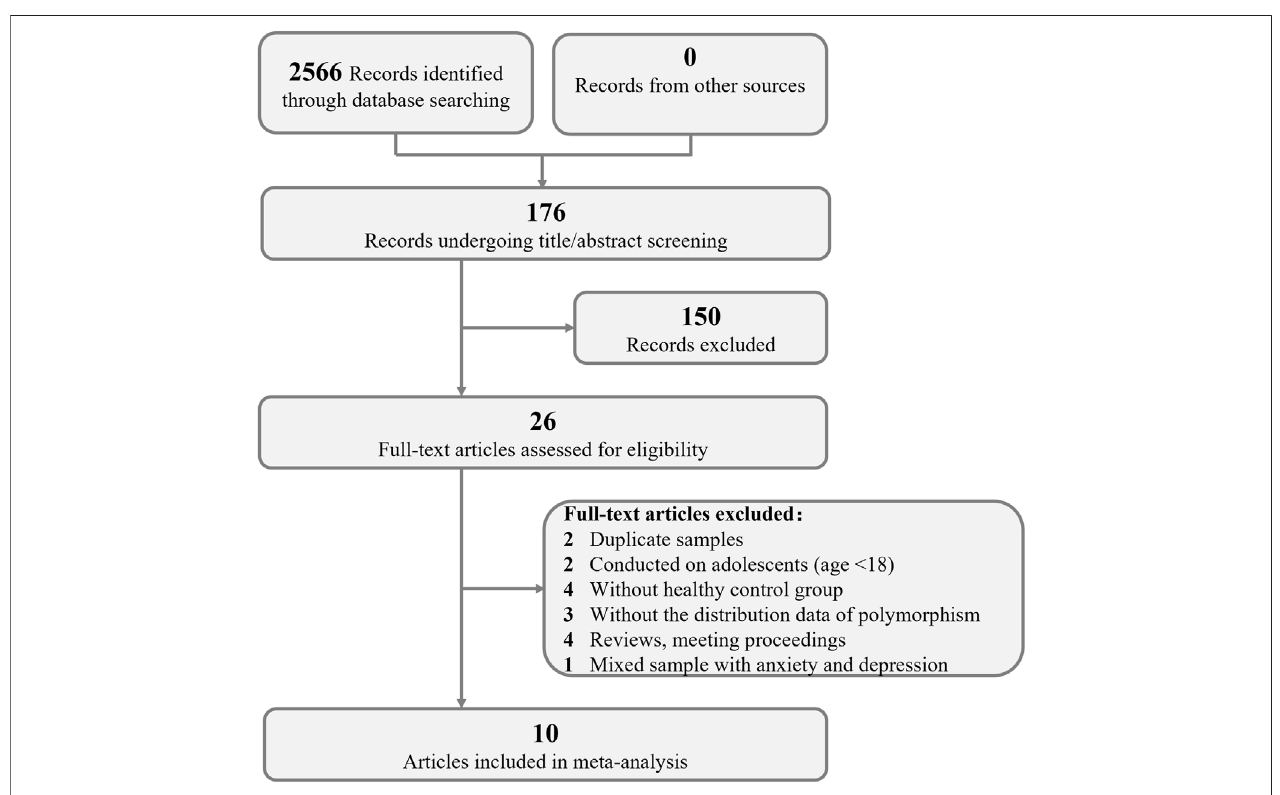
FIGURE 1 | PRISMA fl ow chart of the inclusion and exclusion of studies. PRISMA = Preferred Reporting Items for Systematic Reviews and Meta-Analyses.